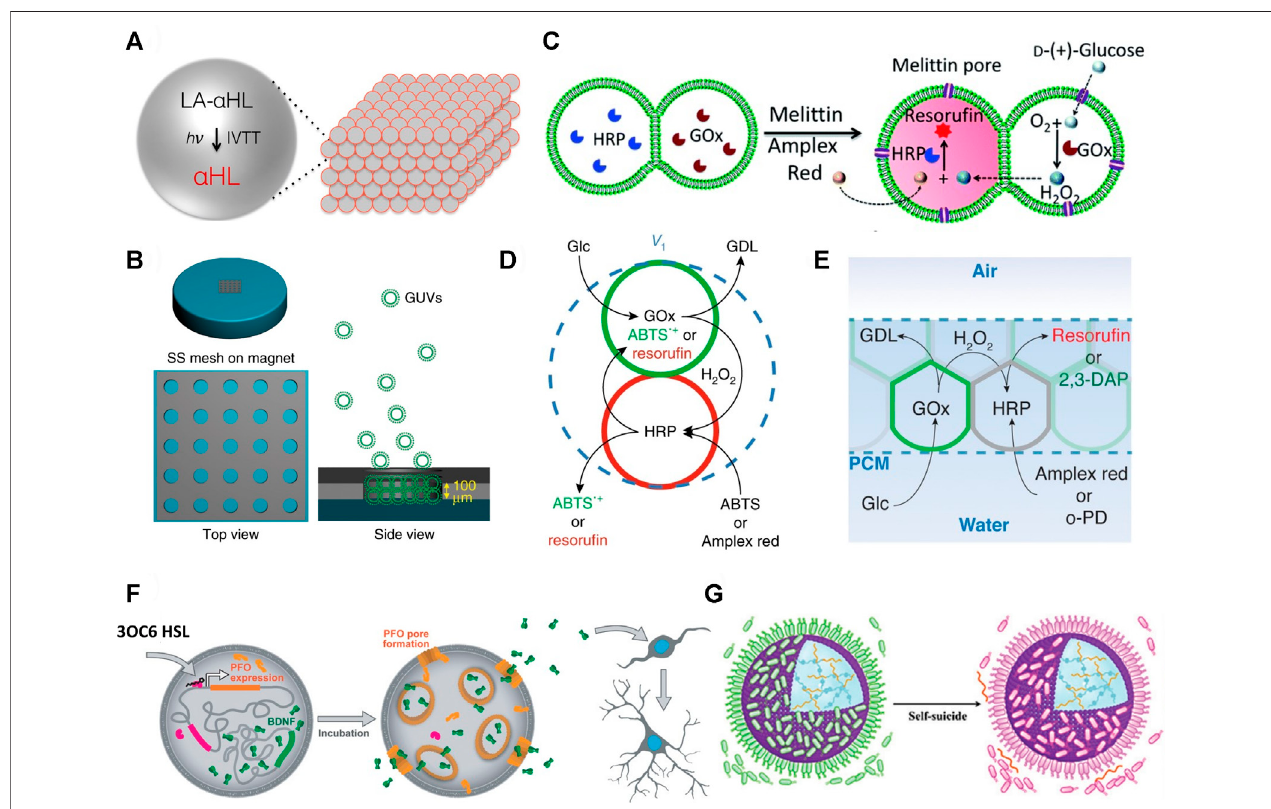
FIGURE 2 | (A) Schematic of light activated communication within a 3D printed synthetic tissue. Light-activated α -hemolysin gene (LA- α HL) is expressed using in vitro transcription-translation system (IVTT). Once synthesised LA- α HL forms protein pores that allow for the exchange of substrates between protocells of synthetic tissues (Booth et al., 2016). (B) Formation of GUV-based prototissues using a magnetic fi eld on a stainless steel (SS) grid (left). Magnetic GUVs (green round shapes) progressively assemble inside the grid to form prototissues guided by the magnetic fi eld (right) (Li et al., 2020). (C) Scheme explaining the reactivity of prototissues comprising hemi-fused GOx- or HRP-loaded GUVs held together byacoustic pressure fi elds. Addition of melittin poreprotein to this system allows entry ofglucoseand Amplex Red. Subsequently, glucose is oxidised to gluconolactone inside the GOx-loaded GUV and the signalling molecule H 2 O 2 is produced. H 2 O 2 diffuses into the other HRP-loaded GUV which catalyses oxidation of Amplex Red to red fl uorescent resoru fi n (Wang et al., 2019). (D) Schematic showing diffusible communication between proteinosomes within a thermoresponsive prototissue spheroid. The input signal glucose (Glc) is converted to gluconolactone (GDL) by GOx inside the green proteinosomes. This reaction also releases the signalling molecule H 2 O 2 which diffuses into the red proteinosomes containing HRP. HRP converts ABTS or Amplex red (cid:129) + orresoru fi n,respectively(Gobboetal.,2018). (E) SchematicofchemicalcommunicationbasedonaGOx/HRPenzymecascadereactionwithina to fl uorescentABTS protocellular material. Details on the reactivity are reported in (d) (Galanti et al., 2021). (F) Mechanism of the chemical “ translation ” carried out by protocells for murine stem cells. The scheme shows a representation of the effects of released BDNF on murine stem cells. BDNF is constitutively expressed in the vesicle but cannot diffuse acrossitsmembrane.When3OC6HSLdiffusesintothearti fi cialvesicle,itinitiatestranscriptionandsubsequenttranslationofPFO.PFOoligomerisesandformsaporein themembraneofthevesicle. Thisallowsexit ofBDNF fromthevesicle. BDNF initiatesdevelopmentand branchingofmurineneural stemcells(Toparlak etal.,2020). (G) Schemeshowinga proteinosome (purplesphere) inducingthedeathof multiple E.coli (green shapes (cid:1) alive;pink shapes (cid:1) dead).The positivelycharged proteinosome surface attracts the negatively charged bacteria. The death of the bacteria is induced through the contact with the ammonium salt present on the proteinosome ’ s membrane and through the pH-mediated release of chitosan oligosaccharides which are bactericides (Zhao et al., 2020). All fi gures adapted from original articles with permission.